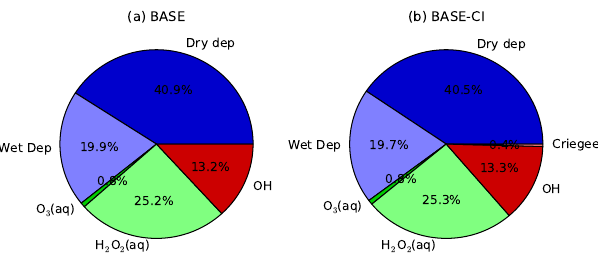
Fig. 2. Fractional contributions of SO 2 -loss pathways predicted for the BASE and BASE-CI simulations (XSOA and XSOA-CI simu- lations give the same respective SO 2